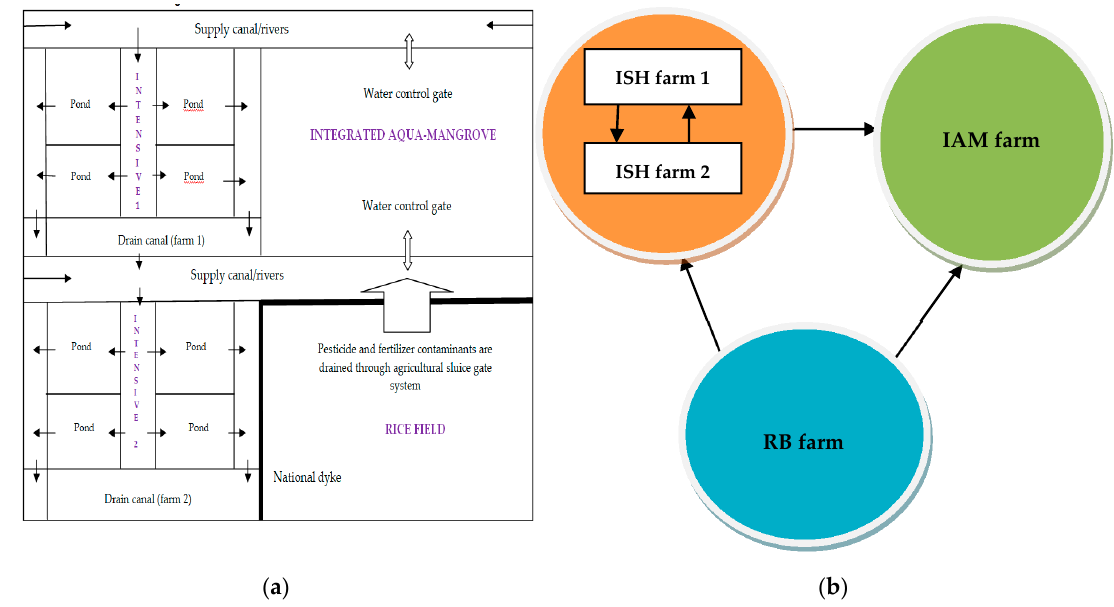
Figure 3. Farm location and design. Note: ( a ) farm designation; ( b )interrelations between systems.